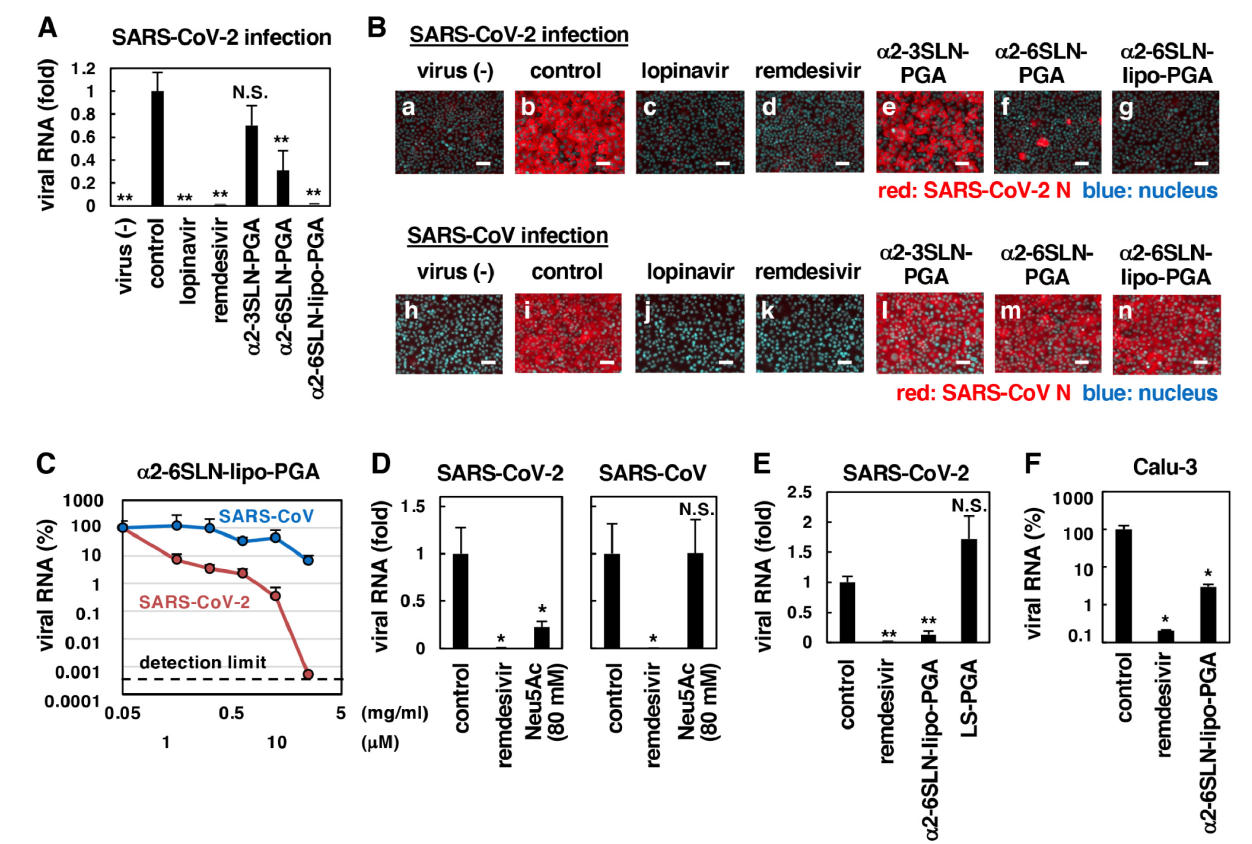
Fig 2. α 2-6SLN-lipo-PGA inhibited SARS-CoV-2 infection. (A, B) SARS-CoV-2 or SARS-CoV infection assays were performed in the presence or absence of the indicated compounds. SARS-CoV-2 or SARS-CoV infection was determined by detecting SARS-CoV-2 RNA in the culture supernatant (A) and viral N protein in the cells (B). Scale bar 50 μ m. Lopinavir, 16 μ M; remdesivir, 10 μ M; α 2-3SLN-PGA, 10 mg/ml; α 2-6SLN-PGA, 10 mg/ml; α 2-6SLN-lipo-PGA, 1 mg/ ml. (C) Dose-response curve of α 2-6SLN-lipo-PGA upon SARS-CoV-2 (red) or SARS-CoV (blue) infection. Secreted viral RNA was quantified upon treatment with α 2-6SLN-lipo-PGA at the concentration as shown. (D, E) Anti-SARS-CoV-2 or anti-SARS-CoV activity of N -acetylneuraminic acid (Neu5Ac, the component of α 2-6SLN-lipo-PGA) and lactosylsphingosine-PGA (LS-PGA, the similar structure with α 2-6SLN-lipo-PGA without having sialic acid). Remdesivir, 10 μ M; Neu5Ac, 80 mM; α 2-6SLN-lipo-PGA, 20 μ M; LS-PGA, 20 μ M. (F) Anti-SARS-CoV-2 activity of indicated compounds in human lung epithelial-derived cell line, Calu-3 cells. Remdesivir, 10 μ M; α 2-6SLN-lipo-PGA, 10 μ M.